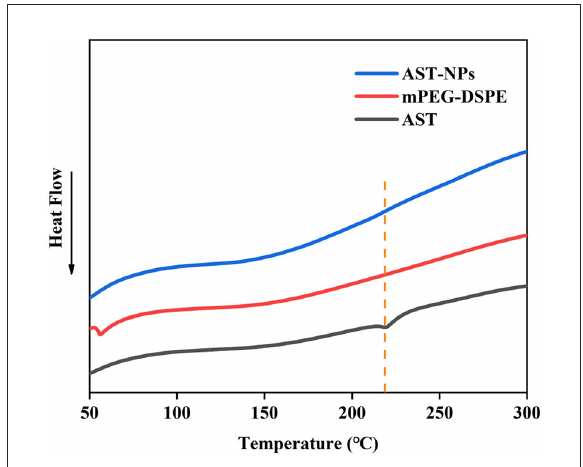
FIGURE4 DSC thermograms of AST-NPs, mPEG-DSPE and free AST.